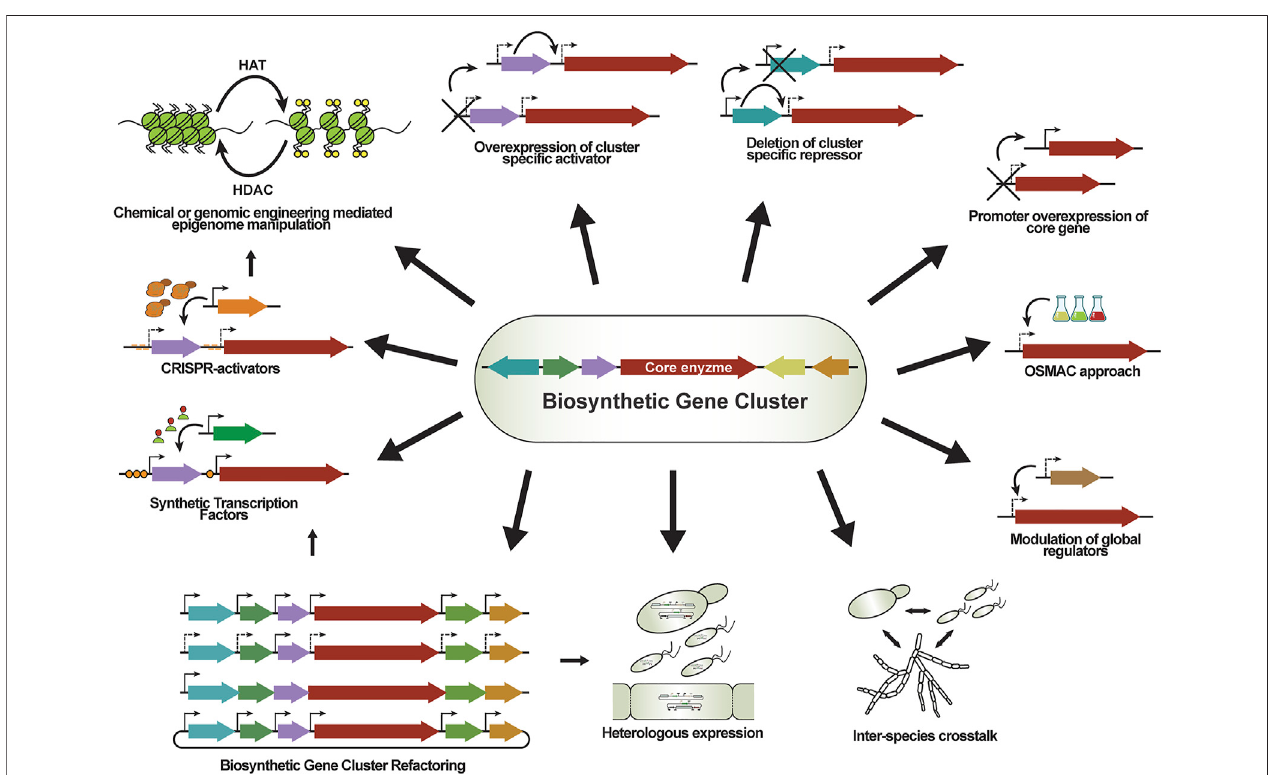
FIGURE2| Strategiesfortranscriptionalactivationforfungalbiosyntheticgeneclusters.Dashedarrowsindicatenative,solidarrowsindicateengineered(strongor inducible) promoters.